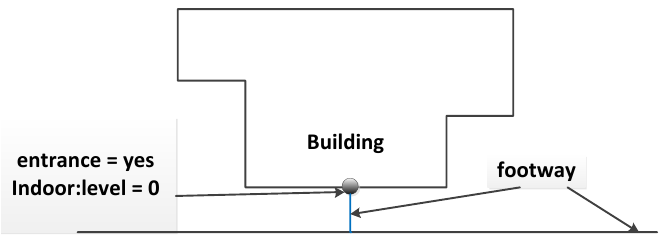
Figure 9. An example of using OSM ways to model the connection between indoor and outdoor environments. An OSM way (in blue) is added to connect an entrance to an outdoor